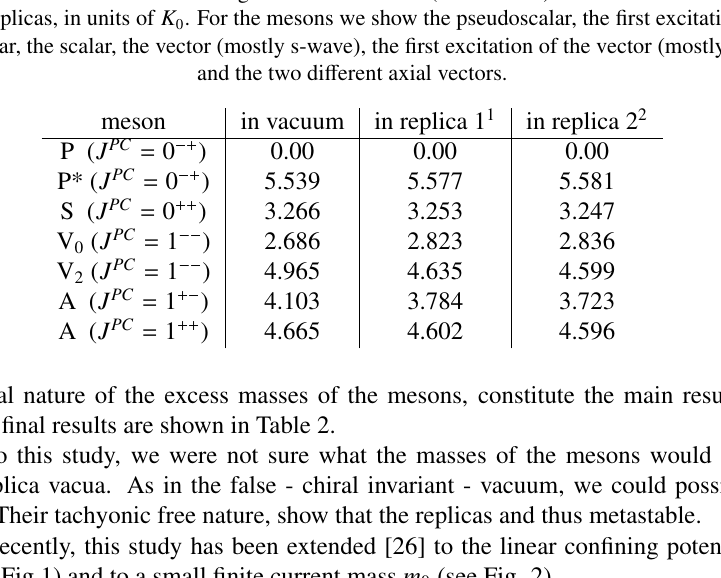
Table 2. Masses of the mesons in the ground state vacuum (the true one) and excess masses 1 , 2 for